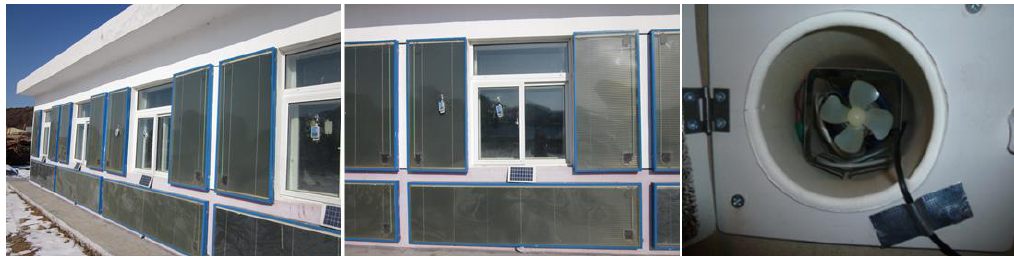
Figure 3. Diagram of PV board and fan.